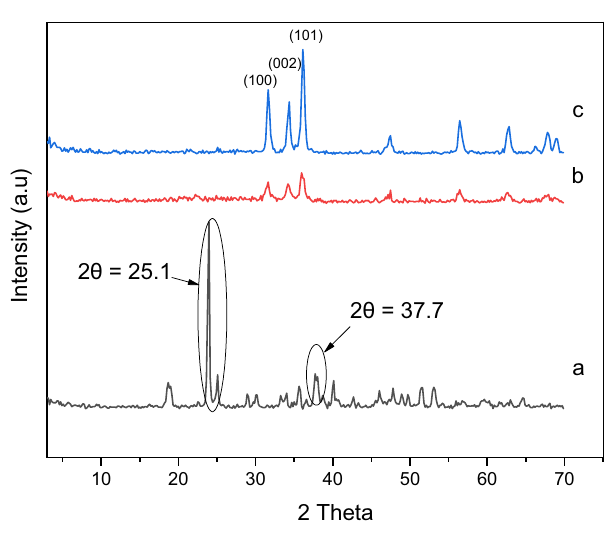
Figure 3. XRD pattern for ZnO/5PVA at calcination ( a ) 300, ( b ) 400 and ( c ) 500